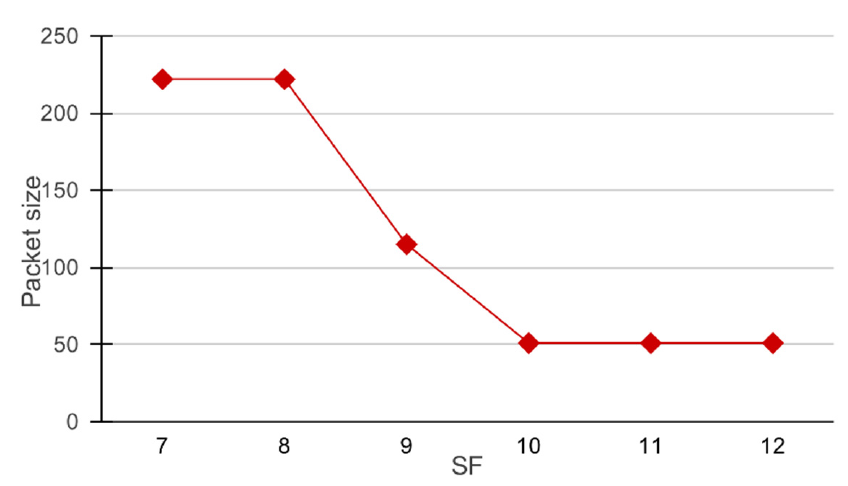
Figure 2. Spreading Factor (SF) versus maximum packet size in LoRa.